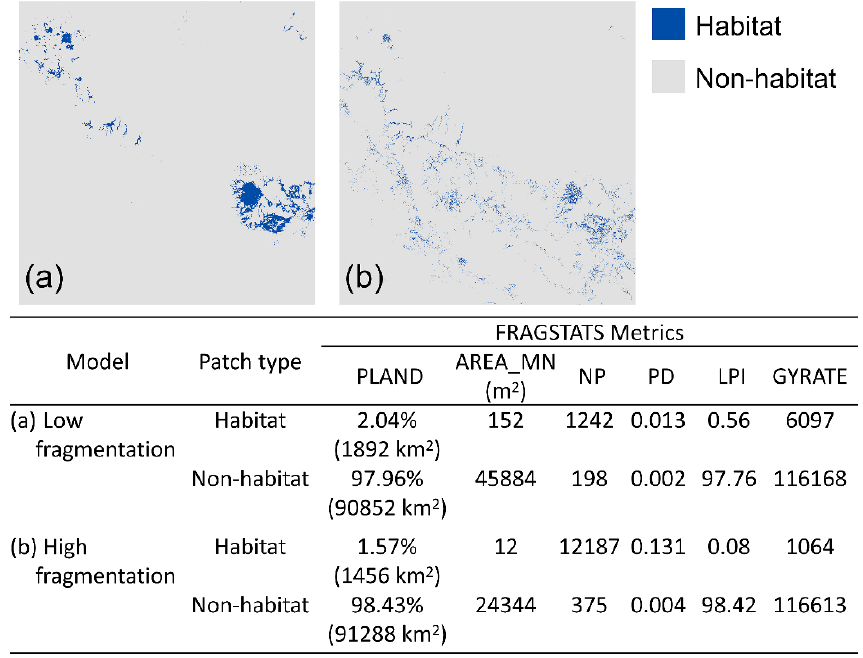
Figure 3. Habitat and non-habitat binary maps predicted by ( a ) low-fragmentation [55] and ( b ) high- fragmentation models [56] using a 0.2 suitability threshold. FRAGSTATS metrics that characterizes fragmentation of habitat and non-habitat patches of the two models are shown in bottom table. PLAND: percentage of landscape, AREA_MN: mean patch size, NP: number of patches, PD: patch density, LPI: largest patch index, and GYRATE: radius of gyration of patches.